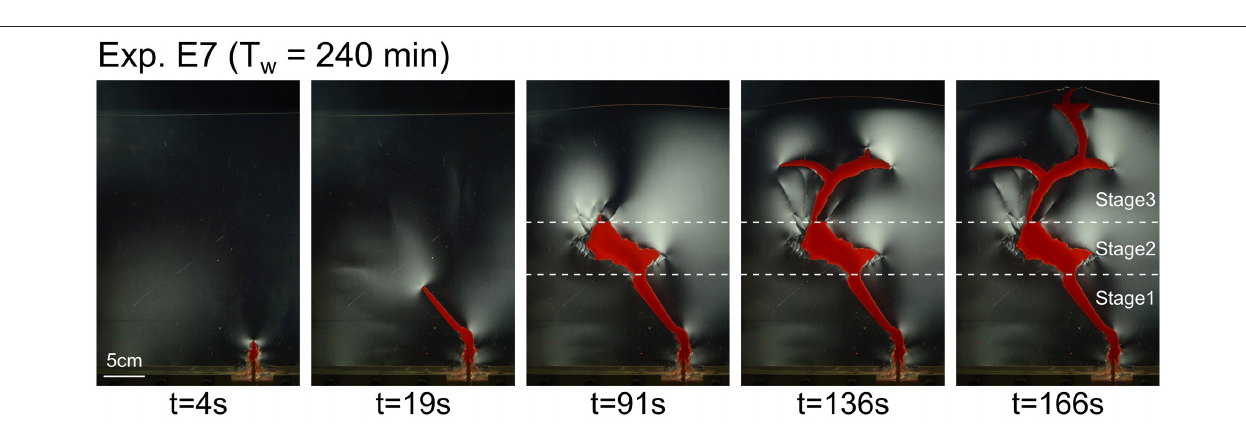
FIGURE 10 | Time series of polarized light photographs of Experiment E7 ( T w = 240